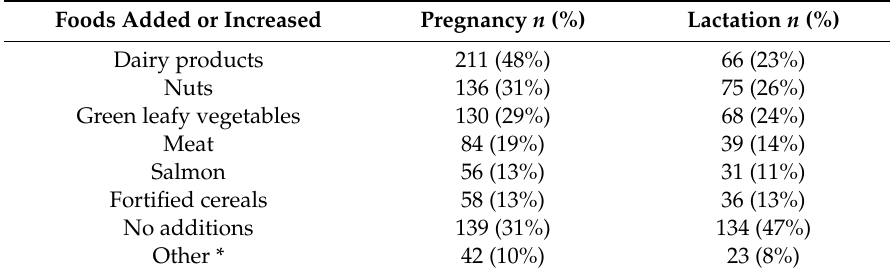
Table 3. Foods and beverages added or increased in the diet during pregnancy and